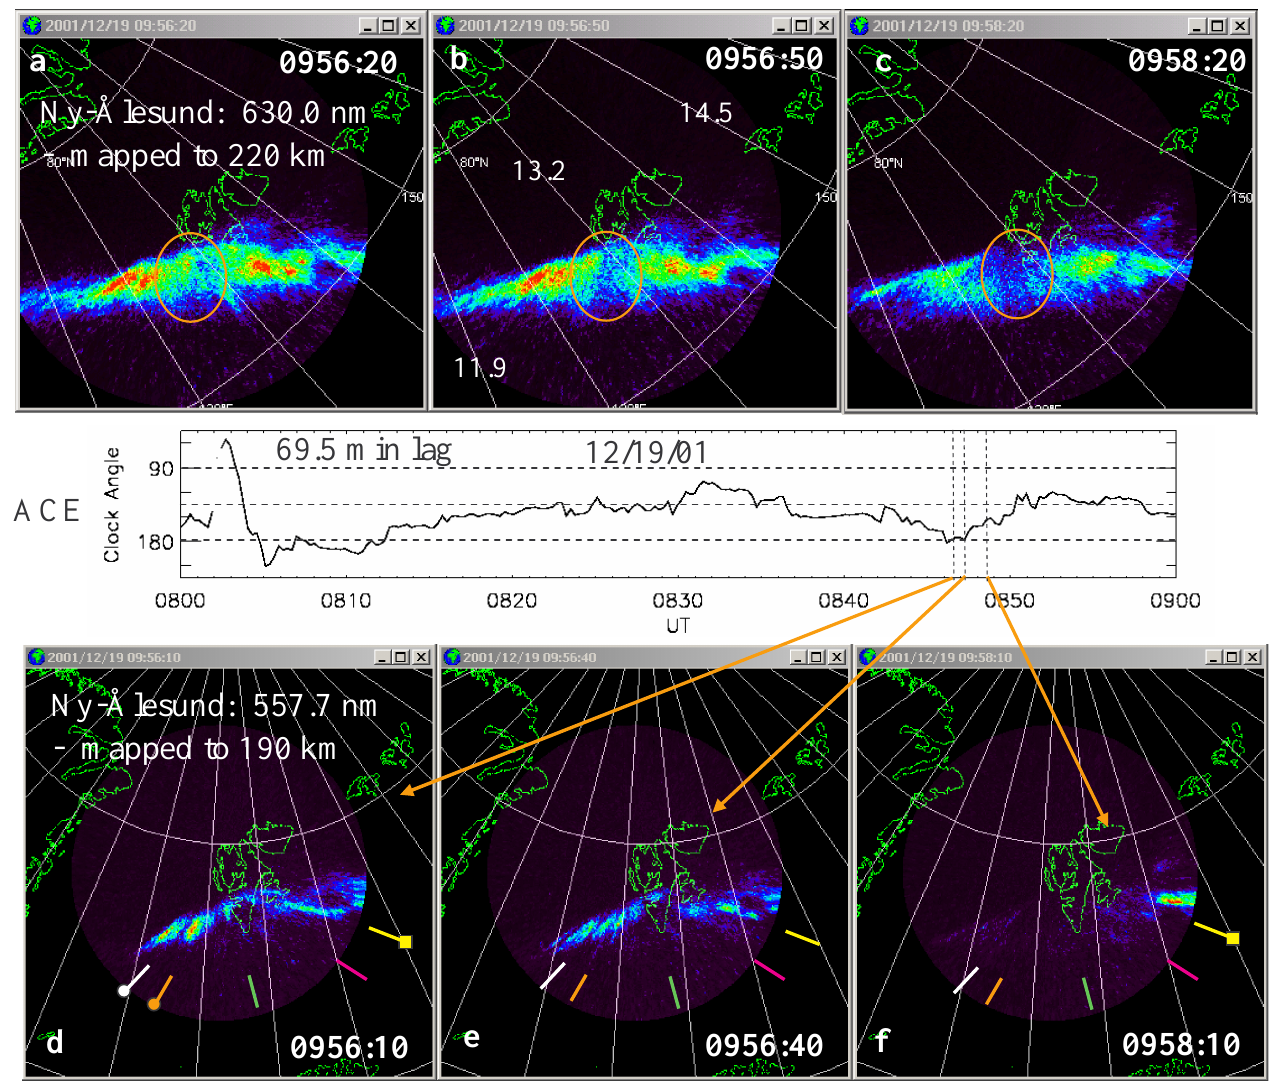
Fig. 9. Continuation of the 630.0- and 557.7-nm emission comparisons for times in Figs. 7d, 7e, and 7f. See caption for Fig. 8.